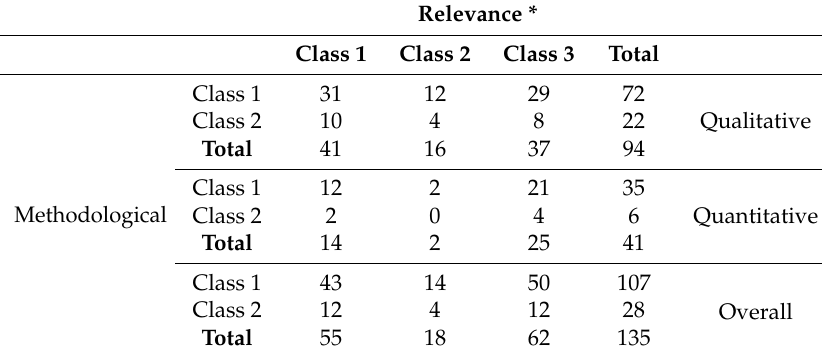
Table 1. Contingency table of methodological quality vs. relevance quality.